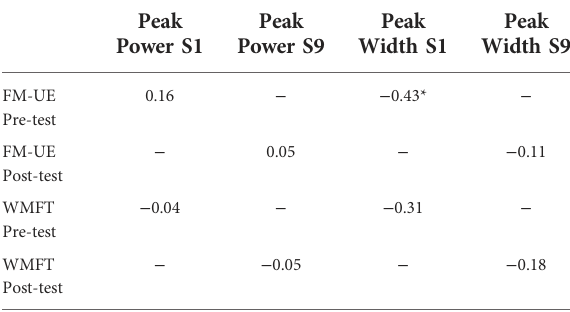
TABLE 2 Correlational analyses between clinical and accelerometry- based metrics. Values marked with * indicate a statistically signi fi cant difference at p